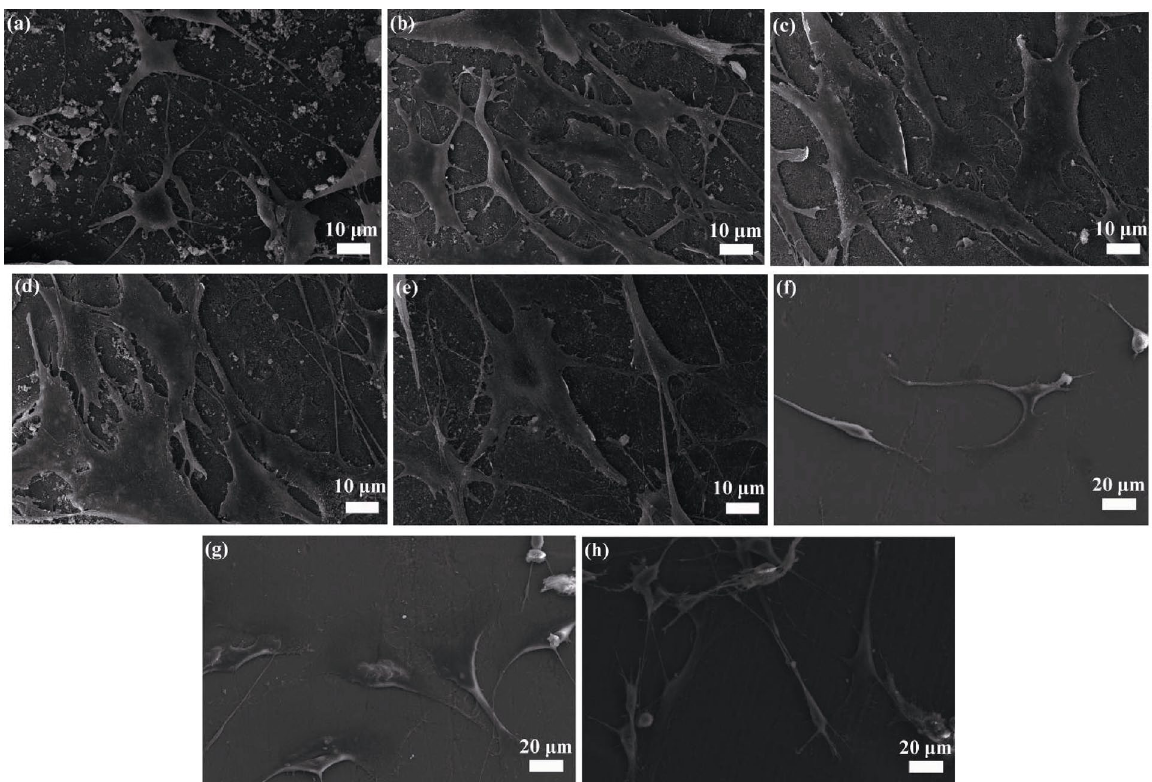
Fig. 5 Proliferation of rBMSCs with porous ceramics and PICN materials after 4 days of proliferation: (a–e) pre-sintered porous ceramics containing 0–4 wt% hydroxyapatite and (f–h) PICN with 0, 1, and 4 wt%